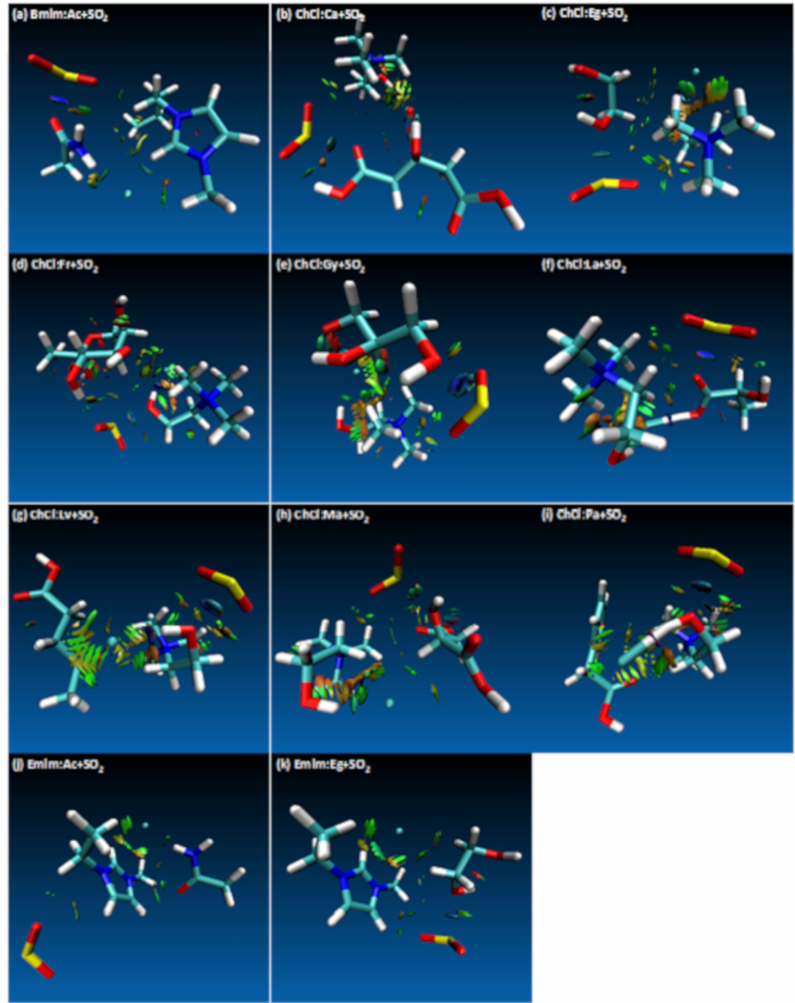
Figure 4. Reduced Density Gradient (RDG) iso-surfaces of the studied systems. van der Waals type of attraction are displayed with green isosurfaces, strong repulsion cases are displayed with red isosurfaces and for strong attractions are displayed with blue isosurfaces.